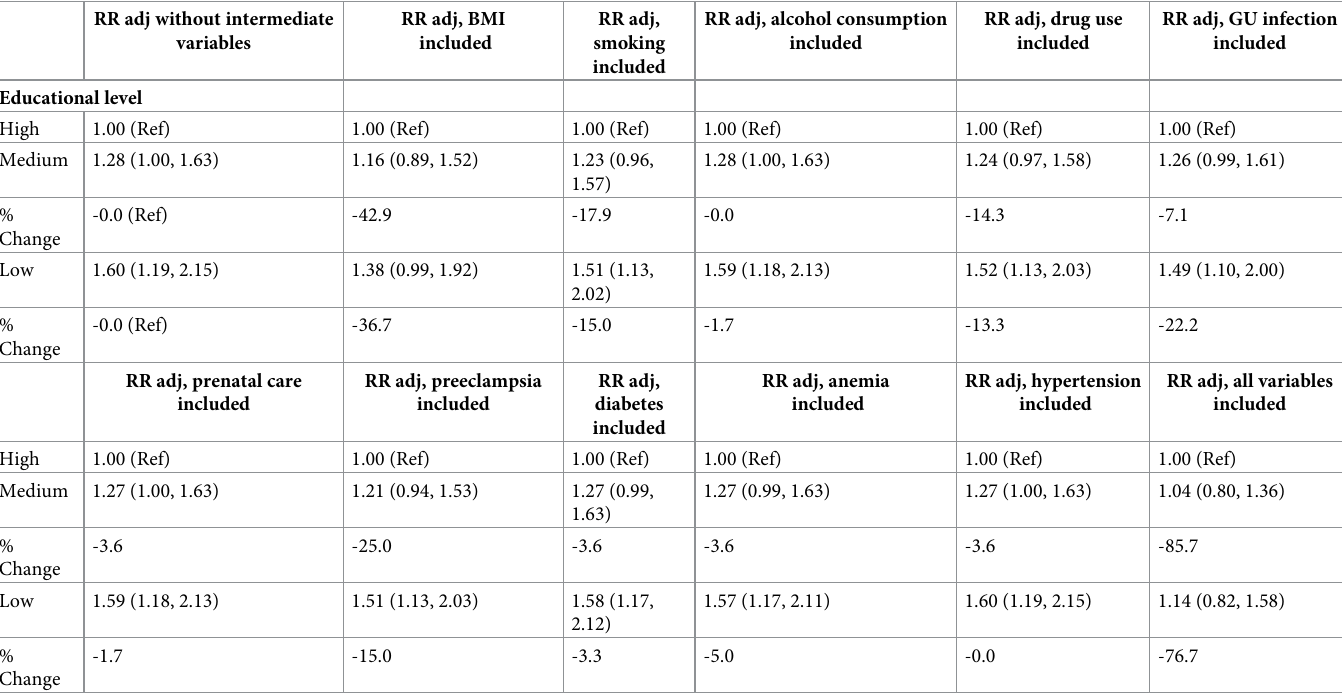
Table 4. RR for the associations between maternal educational level and preterm birth before and after including intermediate variables. RR adj without intermediate